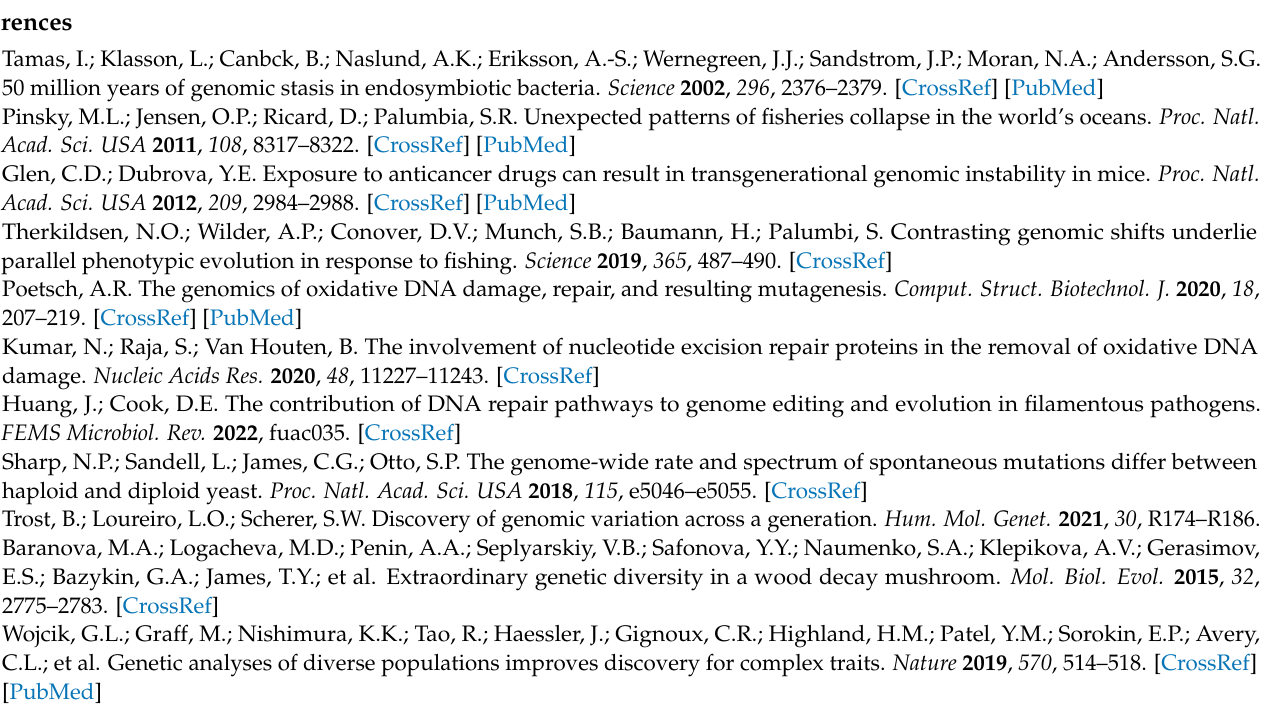
S2: The seven new prediction proteins in the genome of strain PB4; Figure S3A: SNPs distributed in each contig of the strain PB4 compared to the strain 1980; Figure S3B: SNPs distributed in each chromosome of the strain 1980 compared to the strain PB4; Table S1: Data statistics of PacBio reads of PB4; Table S2: Data statistics of Illumina reads of PB4; Table S3: The parameters for de novo genome assembly and annotation of PB4; Table S4: The detailed information of 135 SNPs between the strains PB4 and 1980, validated by